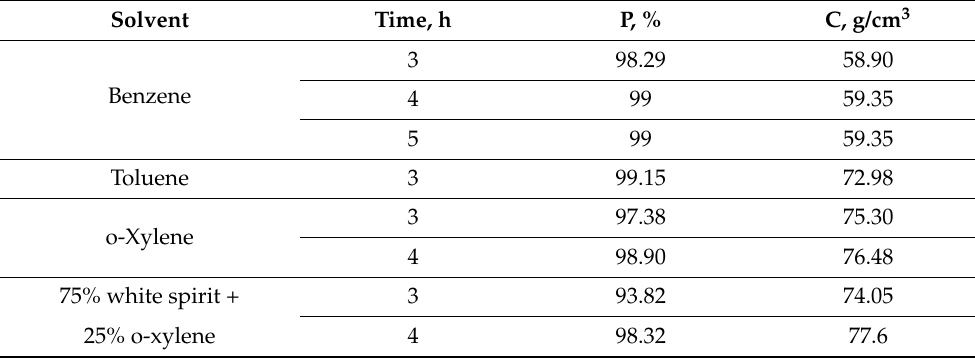
Table 2. Results of tests of the effectiveness of aromatic solvents in relation to the ARPDs of the Zhanaozen field.